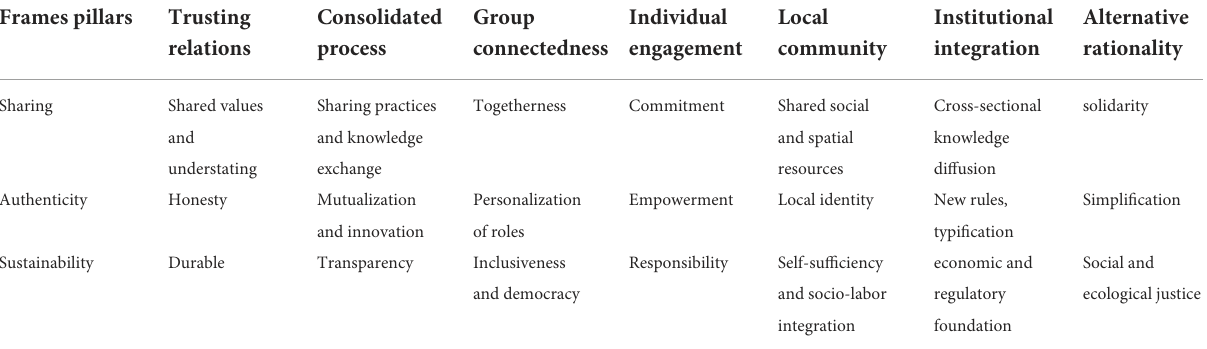
TABLE 2 The frames and the pillars of SFSC. Frames